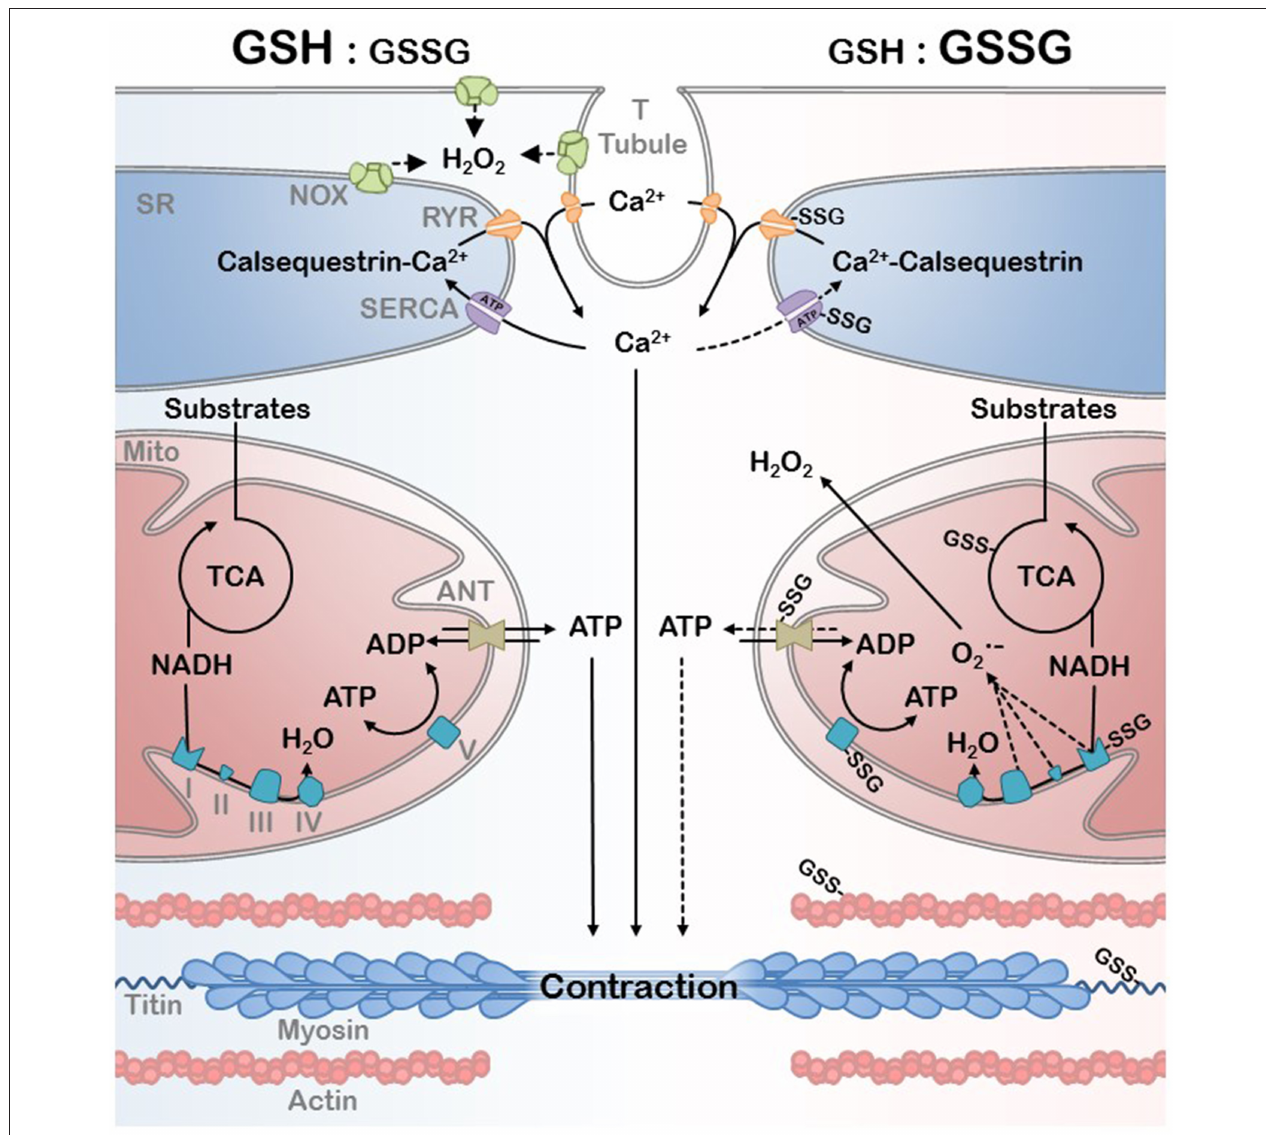
FIGURE 4 | EC coupling and bioenergetics network in a reduced (high GSH:GSSG ratio) and oxidative (low GSH:GSSG ratio) redox environment. Ca 2 + handling by the SR and the ATP generated by the mitochondria are the primary substrates of myofibril contraction. Oxidative PTM can affect the mitochondrial efficiency as well as EC coupling during redox signaling and the oxidative stress associated with disease. Protein S-Glutathioylation of critical mitochondrial, SR, and myofibrillar proteins are depicted as well as the primary sources of H 2 O 2